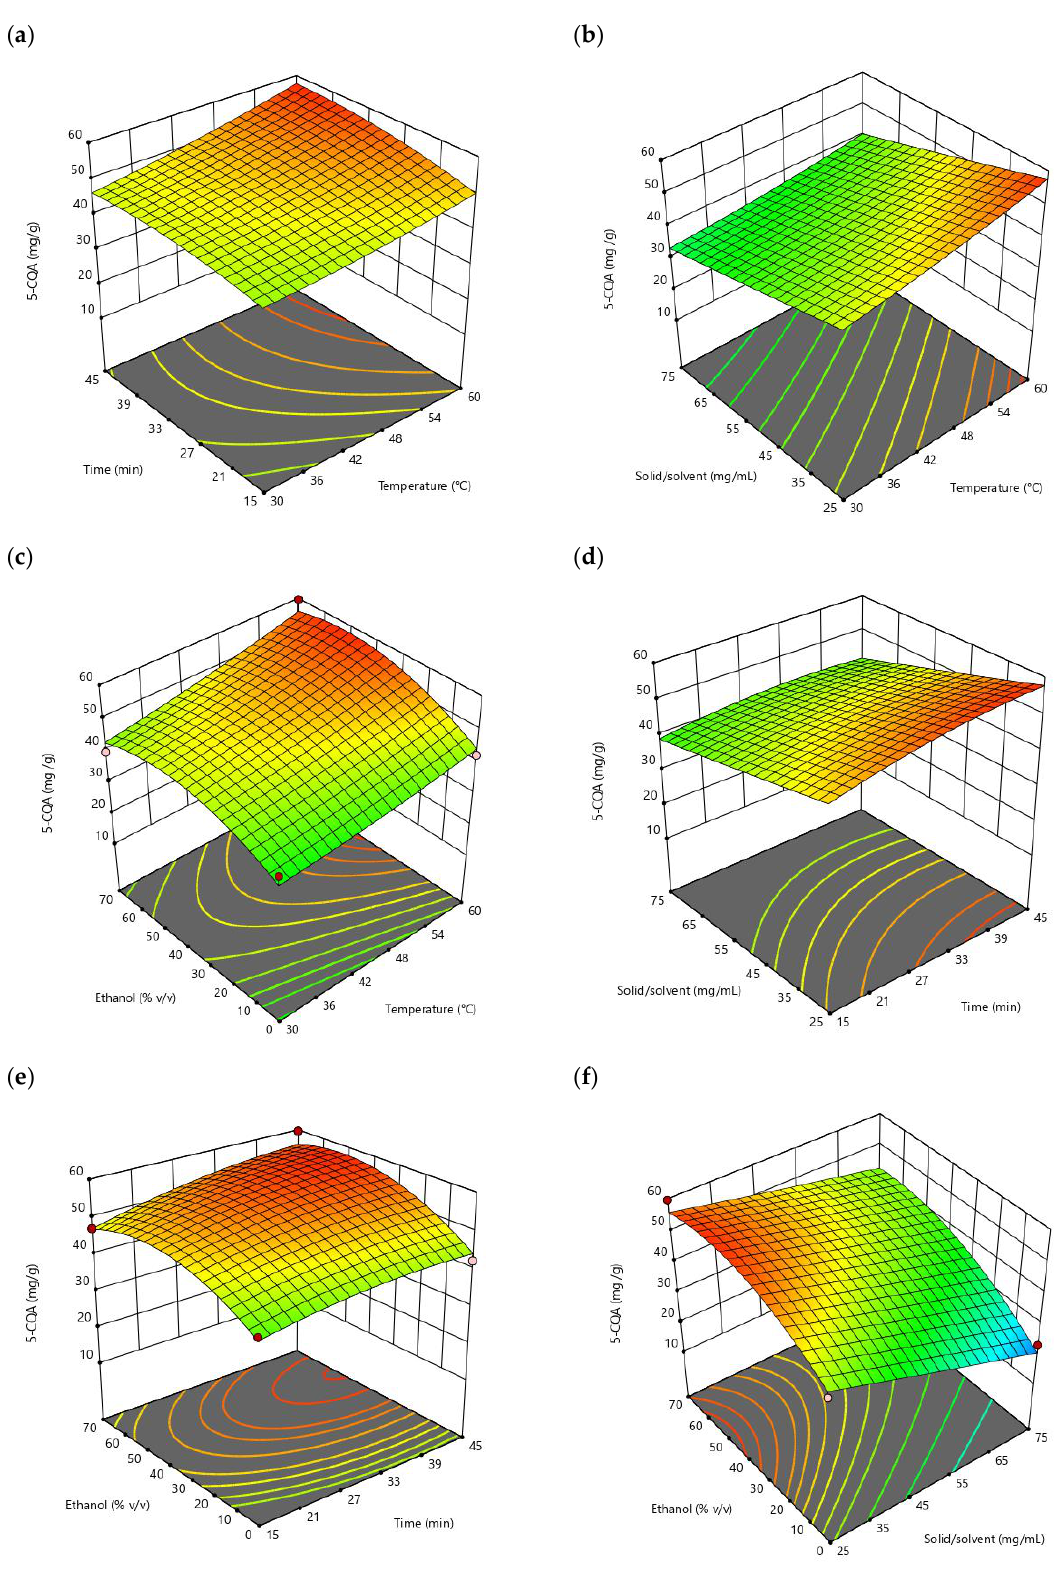
Figure 2. Response-surface representations for the yield of 5-CQA: ( a ) varying temperature and time; ( b ) varying temperature and solid/solvent ratio; ( c ) varying temperature and % ethanol; ( d ) varying time and solid/solvent ratio; ( e ) varying time and % ethanol; ( f ) varying solid/solvent ratio and % ethanol.